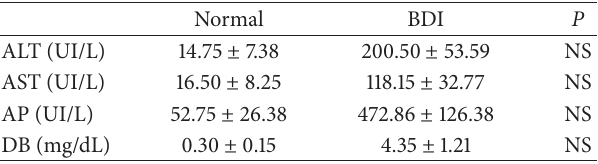
Table 1: Liver enzymes. Serum levels of liver enzymes were increased before the biliary digestive reconstruction in BDI patients without significant difference versus healthy